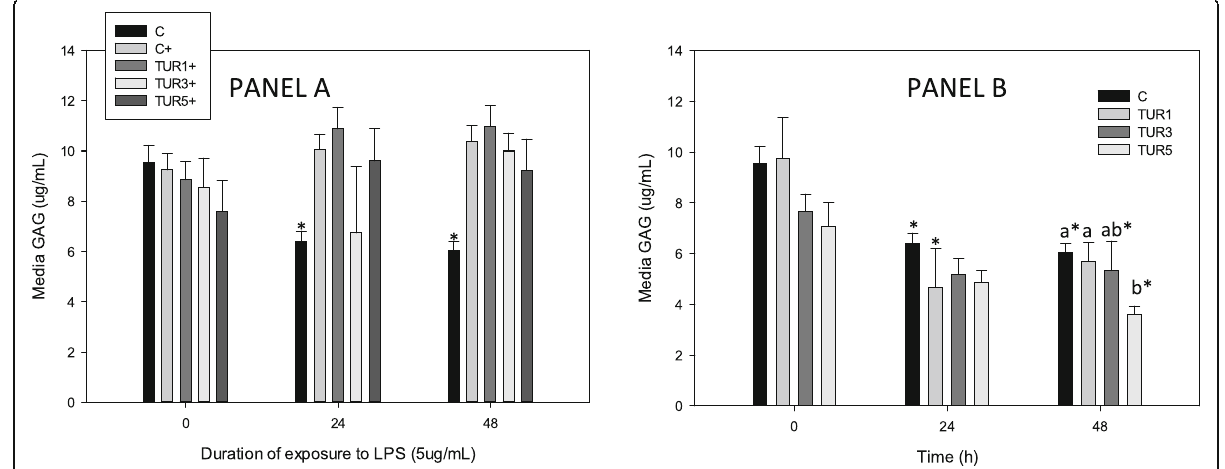
Fig. 2 GAG production by cartilage explants ( n = 8 pigs) conditioned with simulated biological extract of turmeric (3, 9 or 15 μ g/mL; TUR1, TUR3 and TUR5 respectively) compared with simulated biological extract containing no turmeric (C) in the presence (Panel a ) or absence (Panel b ) of lipopolysaccharide (LPS; 5 μ g/mL) (+). Explants were cultured for a total of 96 h and were conditioned with TUR for the first 48 h prior to exposure to LPS. Data are shown for the final 48 h only. * denotes significant change from baseline within treatments. Letters denote significant differences between treatments at specific time points